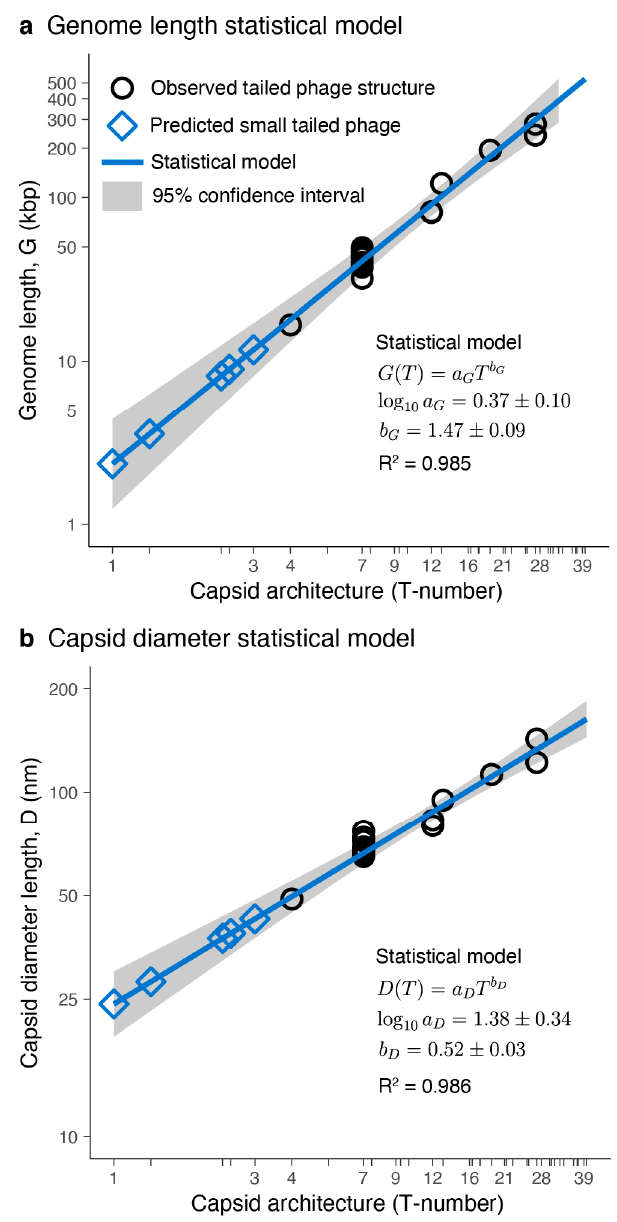
Figure 3. Tailed phage statistical models. Genome length ( a ) and capsid diameter ( b ) plotted as a function of capsid architecture for the studied tailed phage structures (black circles) and the predicted small-tailed phage structures (blue diamonds). ( a , b ) The solid blue lines and grey areas correspond, respectively, to the mean values and 95% confidence interval predicted from the statistical model. The mean values and standard errors of the fitted parameters, as well as the coefficient of determination (R 2 ), are displayed.